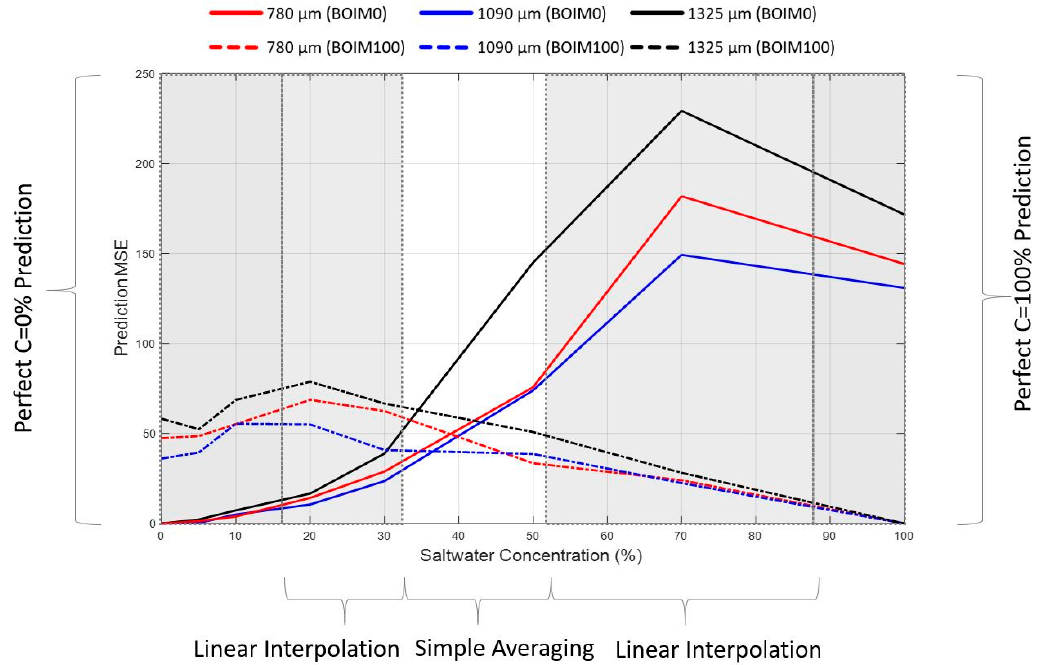
Figure 10. MSE generated by the BOIM0 and BOIM100 modified subsets for the three homogeneous aquifers and the proposed optimum combination of the predictions.